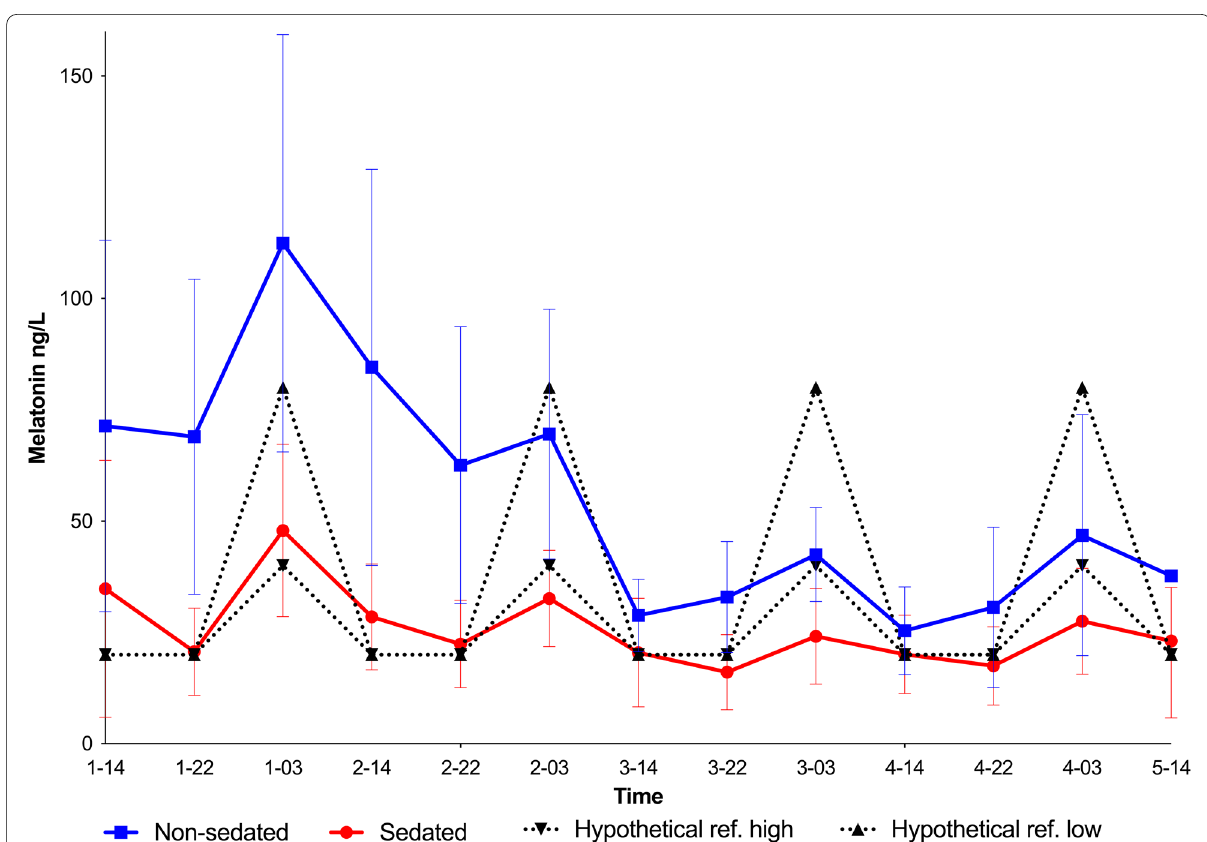
Fig. 2 Mean melatonin concentration throughout the 4-day study period including 95% confidence interval. X axis; day and time of the sample (e.g., 2–14 day 2 time 14:00). The reference curve is hypothetical and based on the literature, mainly M. Karasek et al. and demonstrates mean = concentration of melatonin diurnal variation among healthy individuals in the age group of the study population [5, 12,